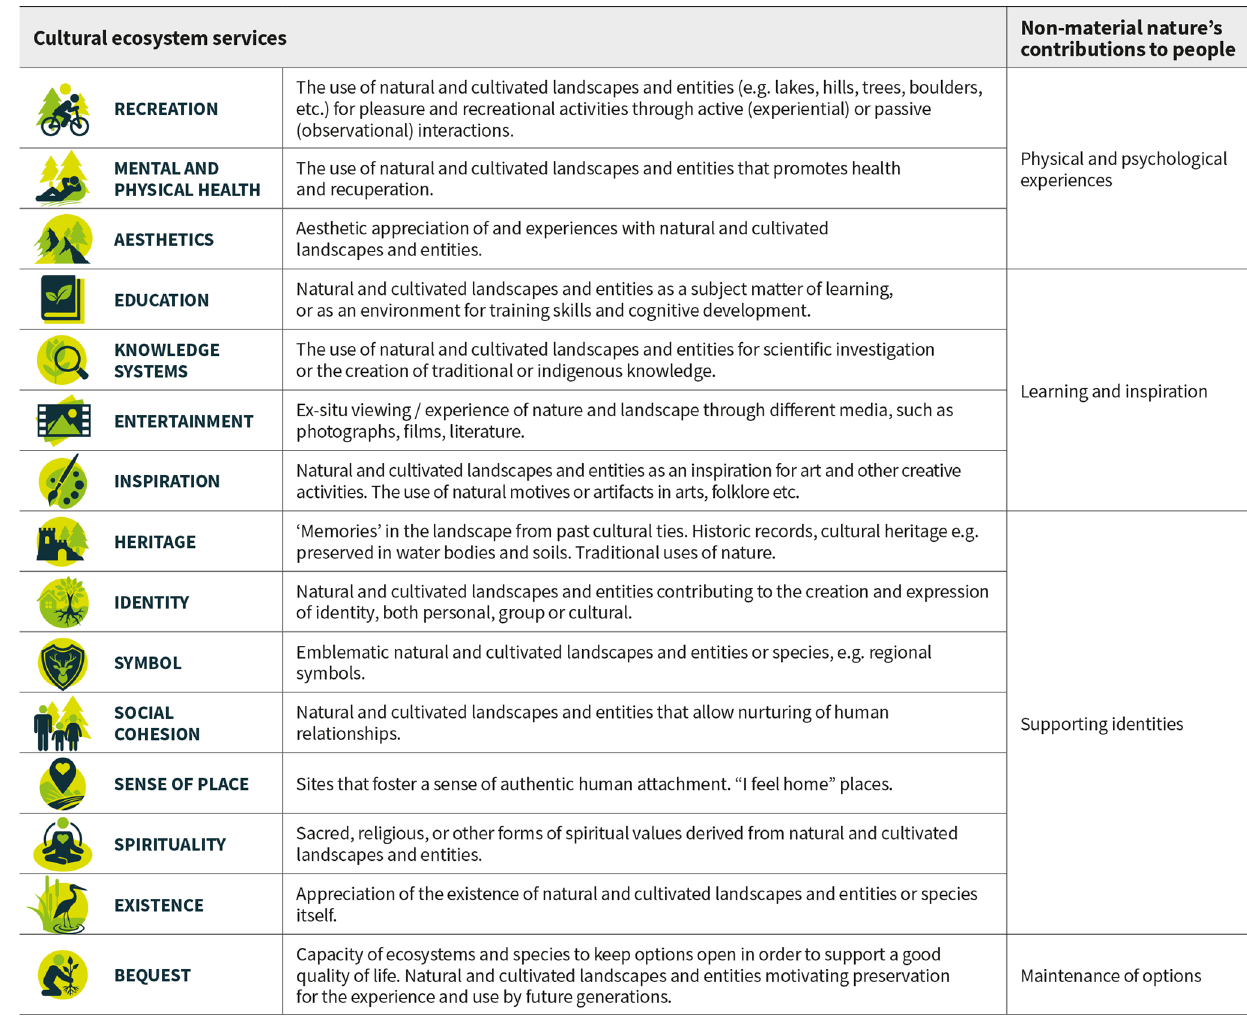
Fig. 1 CES classi fi cation applied in the review. CES categories used in this paper (including their description) and their accordance tonon-material nature ’ s contributions to people (for the description of NCP categories see Díaz et al.,